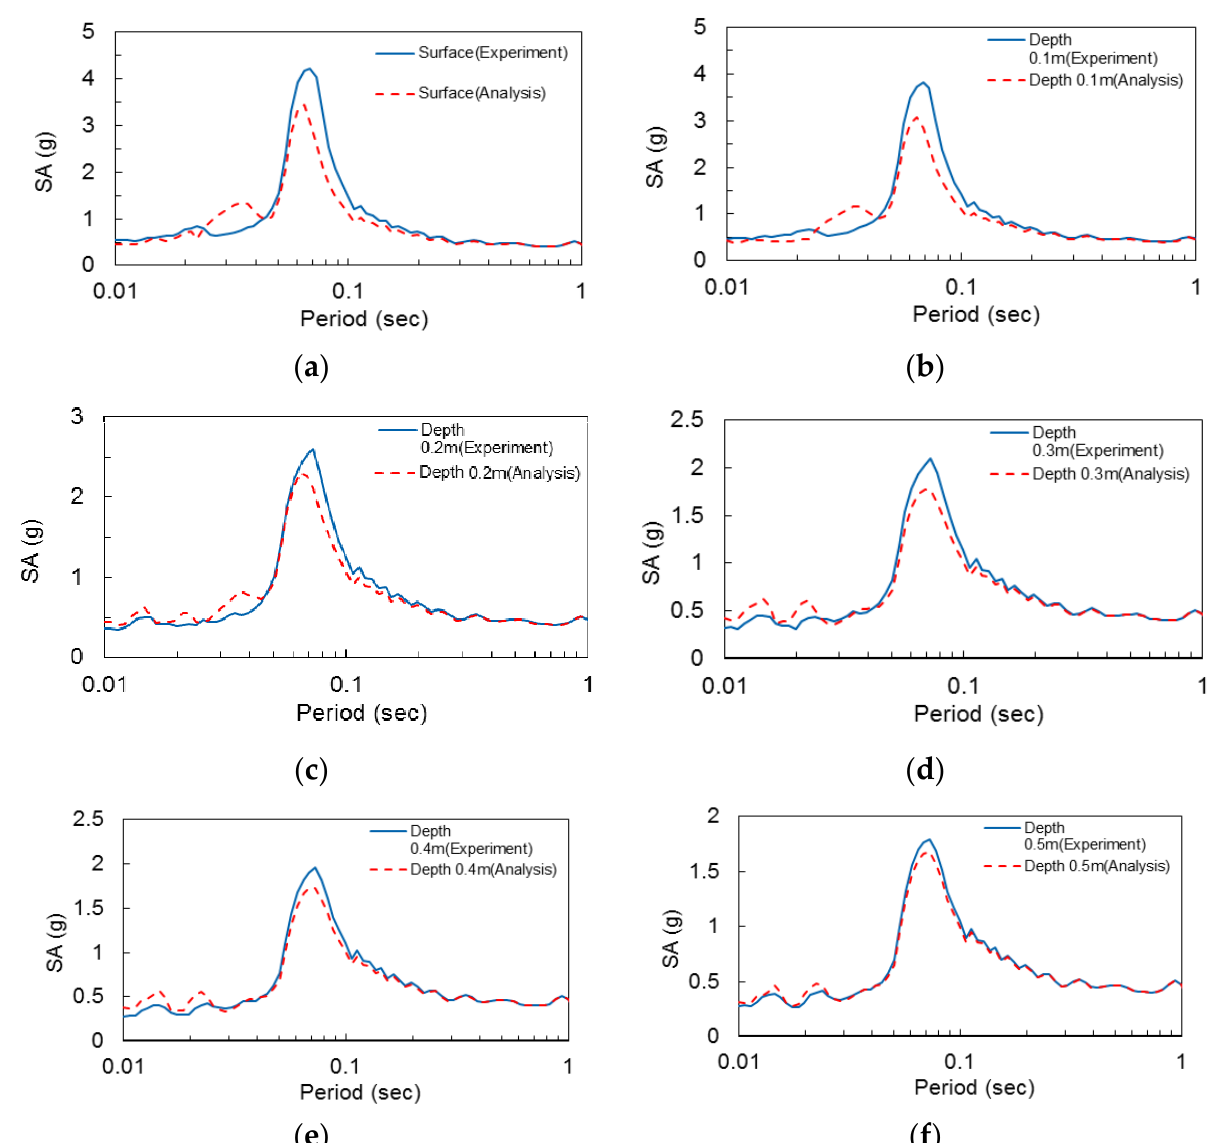
Figure 16. ( a ) SA by sine sweep at surface; ( b ) SA by sine sweep at 0.1 m depth; ( c ) SA by sine sweep at 0.2 m depth; ( d ) SA by sines weep at 0.3 m depth; ( e ) SA by sine sweep at 0.4 m depth; ( f ) SA by sine sweep at 0.5 m depth.